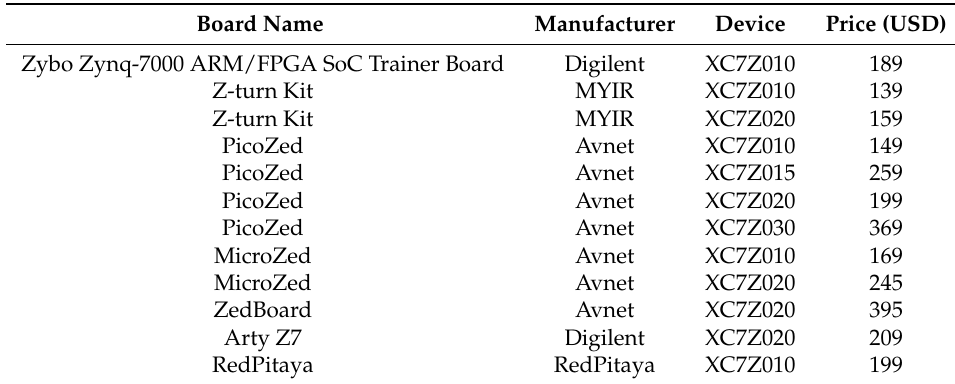
Table 7. Commercial devices which include Zynq